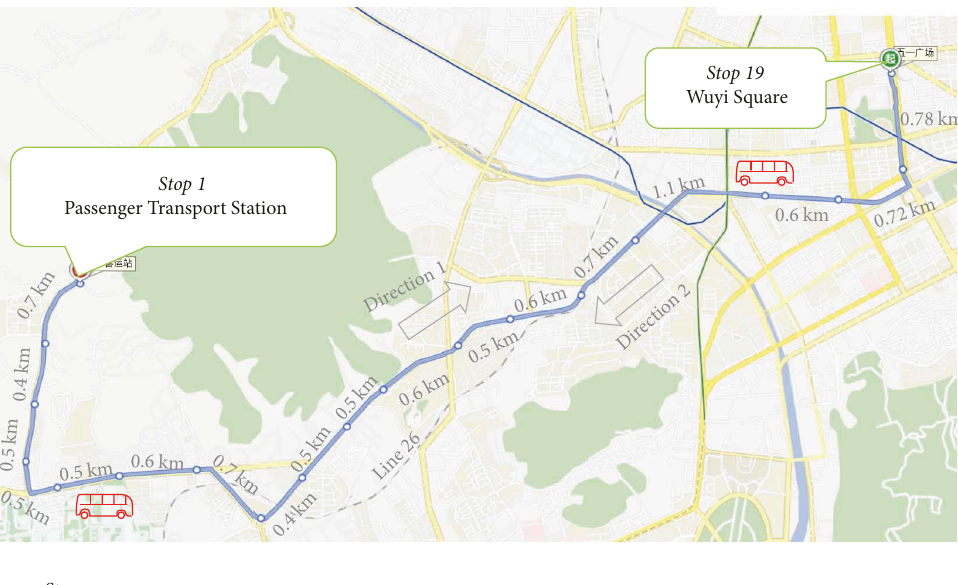
Figure 1: A real life transit route, Line 26, in Dalian.